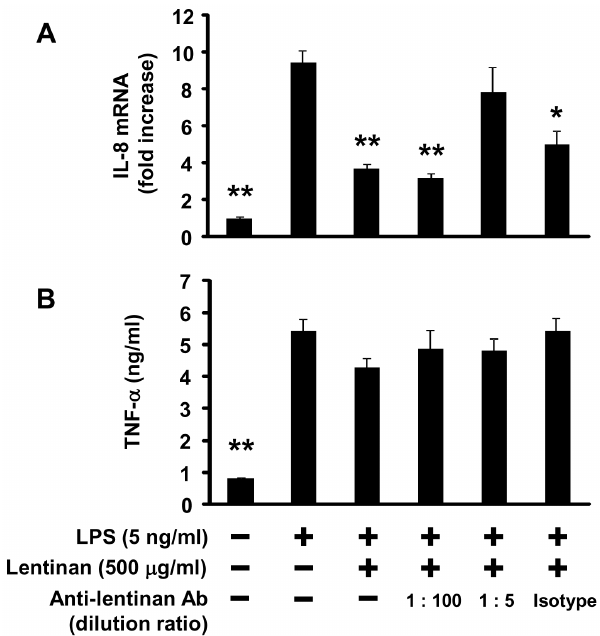
Figure 8. Effect of anti-lentinan polyclonal Ab on lentinan inhibition of IL-8 mRNA expression in Caco-2 cells. A rabbit polyclonal anti-lentinan Ab was diluted with PBS at ratios of 1:5 or 1:100, and then mixed with lentinan solution and incubated on ice for 30 min. A rabbit polyclonal isotype control Ab was used as control at the same protein concentration as anti-lentinan Ab (dilution ratio of 1:5). Antibody-treated lentinan (500 m g/ml) was added into the apical compartment of a co-culture model for 3 h. Subsequently, LPS was added to the basolateral compartment at a concentration of 5 ng/ml, followed by incubation for an additional 3 h. IL-8 mRNA expression in Caco-2 cells was determined by quantitative RT-PCR. (B) TNF- a production in the basolateral compartment was determined by a L929 cytotoxicity assay. The values represent the means 6 SE. Experiments were repeated for three times in triplicate. * P , 0.05, ** P , 0.01 vs. LPS control.